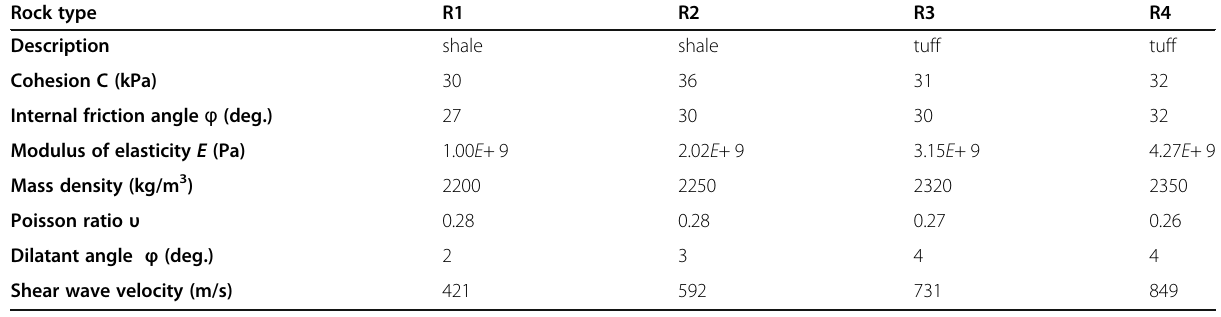
Table 1 Characteristics of soil medium